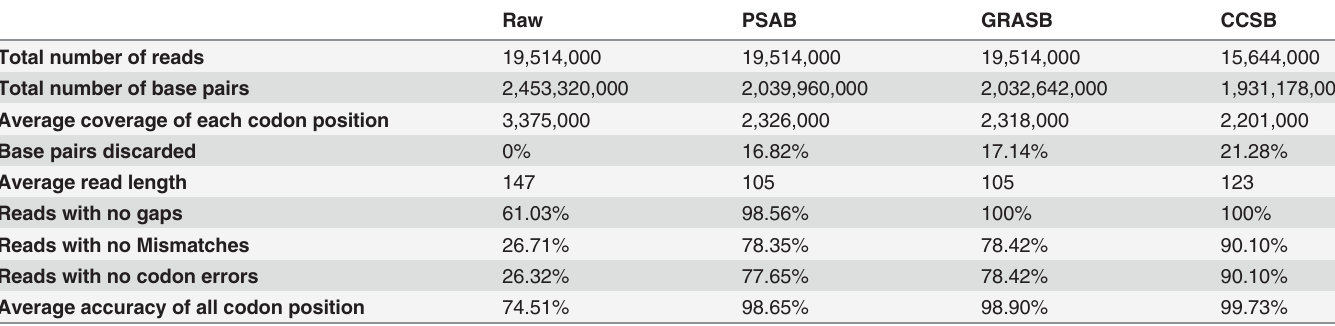
Table 1. Analysis of M237I sample set at each step of fi ltering procedure. Raw PSAB